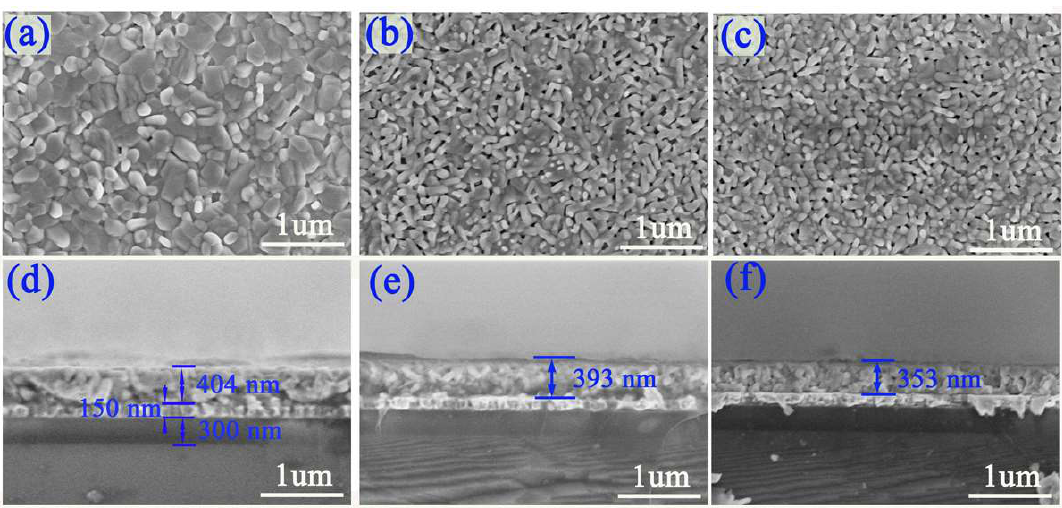
Figure. 2. SEM surface and cross-section images: ( a , d ) for BTM; ( b , e ) for BNTM05; ( c , f ) for BNTM85.